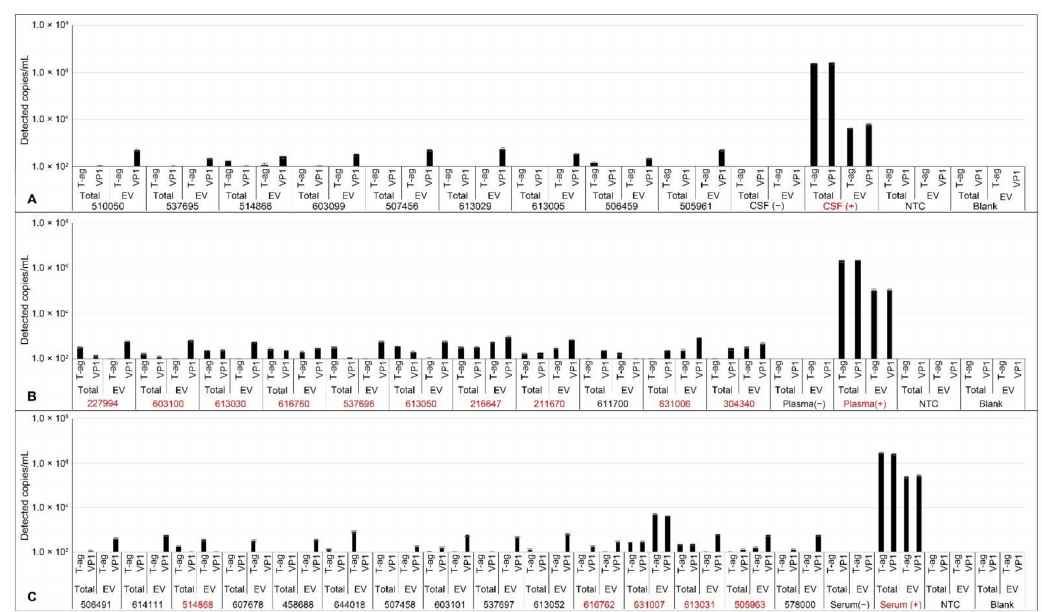
Figure 8. Individual ddPCR results for detection of JCPyV in CSF ( A ), plasma ( B ), and serum ( C ). EV were isolated using size-exclusion chromatography mini columns followed by ultrafiltration using Amicon Ultra-4 columns. Purified and concentrated EV were processed according to the workflow diagram and analyzed by ddPCR for JCPyV genomes. Total samples were DNA extracted, digested, and similarly analyzed. The y-axis represents 120 copies/mL and is the equivalent of two positive drops at the correct amplitude. JCPyV-positive samples are shown in red. Error bars represent the standard error.